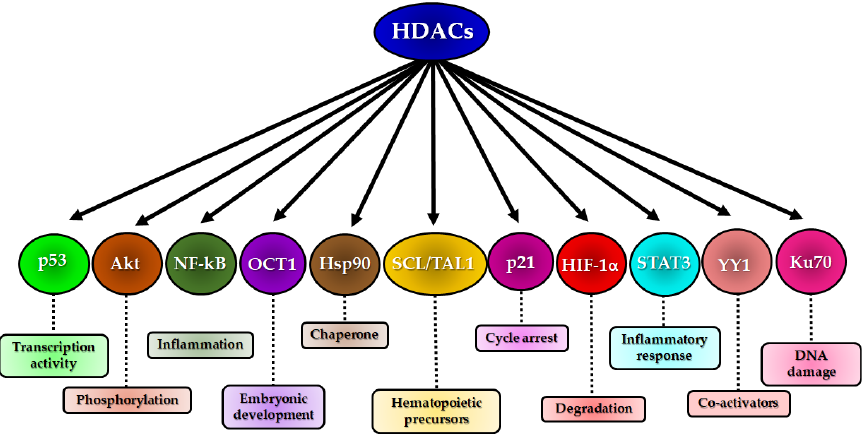
Figure 4. Some non-histone proteins affected by histone deacetylases (HDACs) and the changes caused by these interactions.